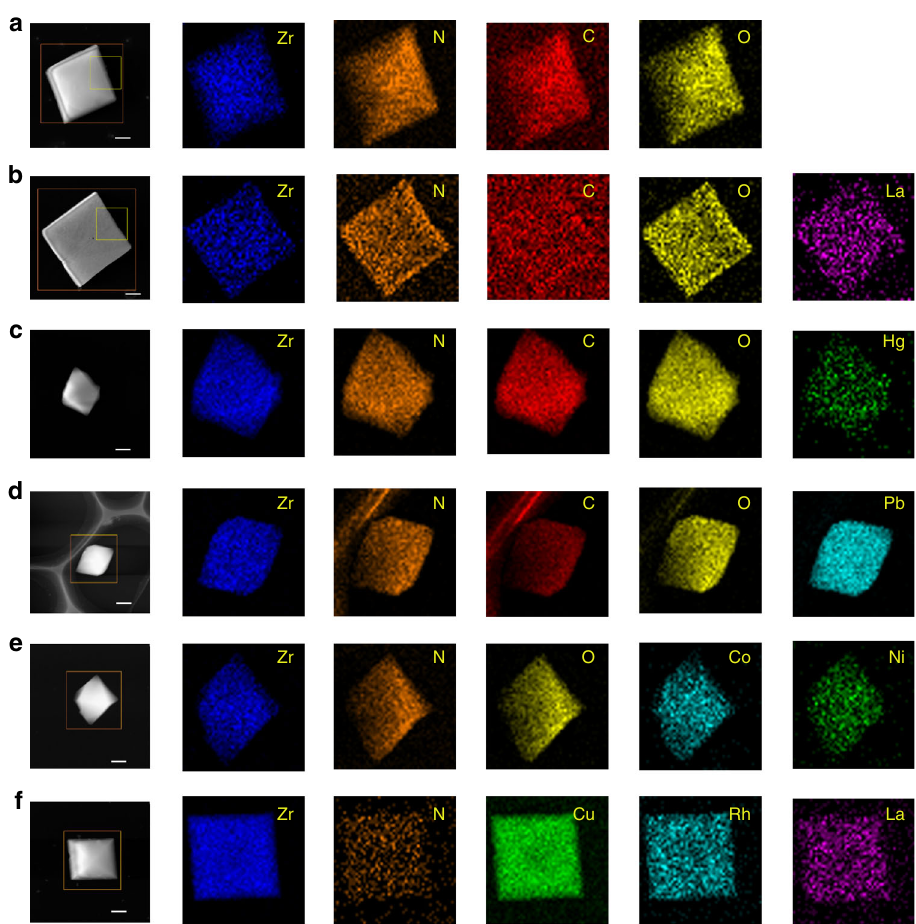
Fig. 6 Dispersity of metal ions in MOF-808-EDTA. STEM-HAADF images (scale bar, 100 nm) and the corresponding elemental maps for a MOF-808- EDTA, b – d single-metal systems (MOF-808-EDTA with loaded La 3+ , Hg 2+ , and Pb 2+ , respectively), e binary system (MOF-808-EDTA with loaded Co 2+ and Ni 2+ ), and f ternary system (MOF-808-EDTA with loaded Cu 2+ , Rh 3+ and Ru 3+